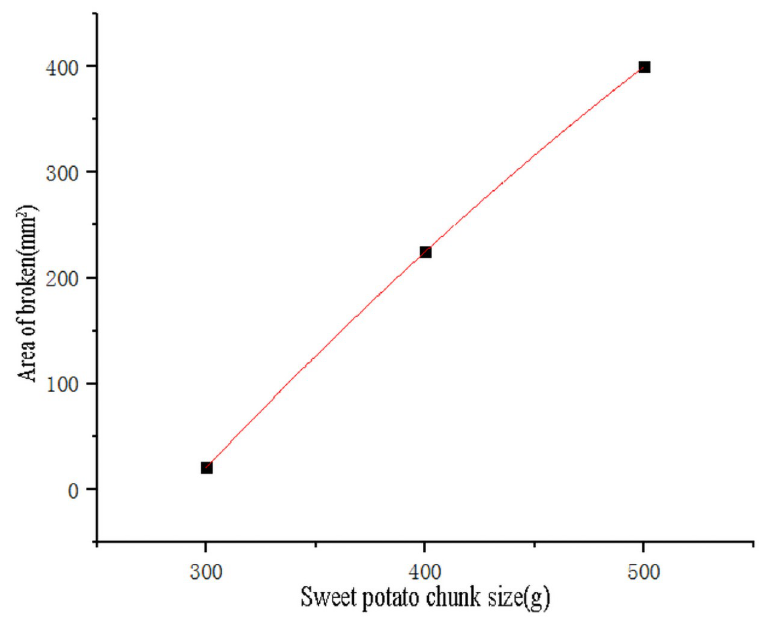
Fig 19. Fitting curve of sweet potato chunk size and the area of